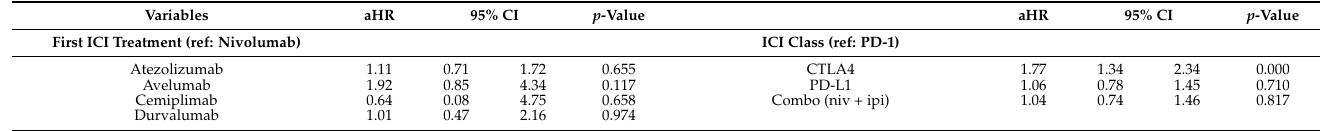
Table 3. Hazard ratios for risk of cardiotoxicity estimated from competing risk